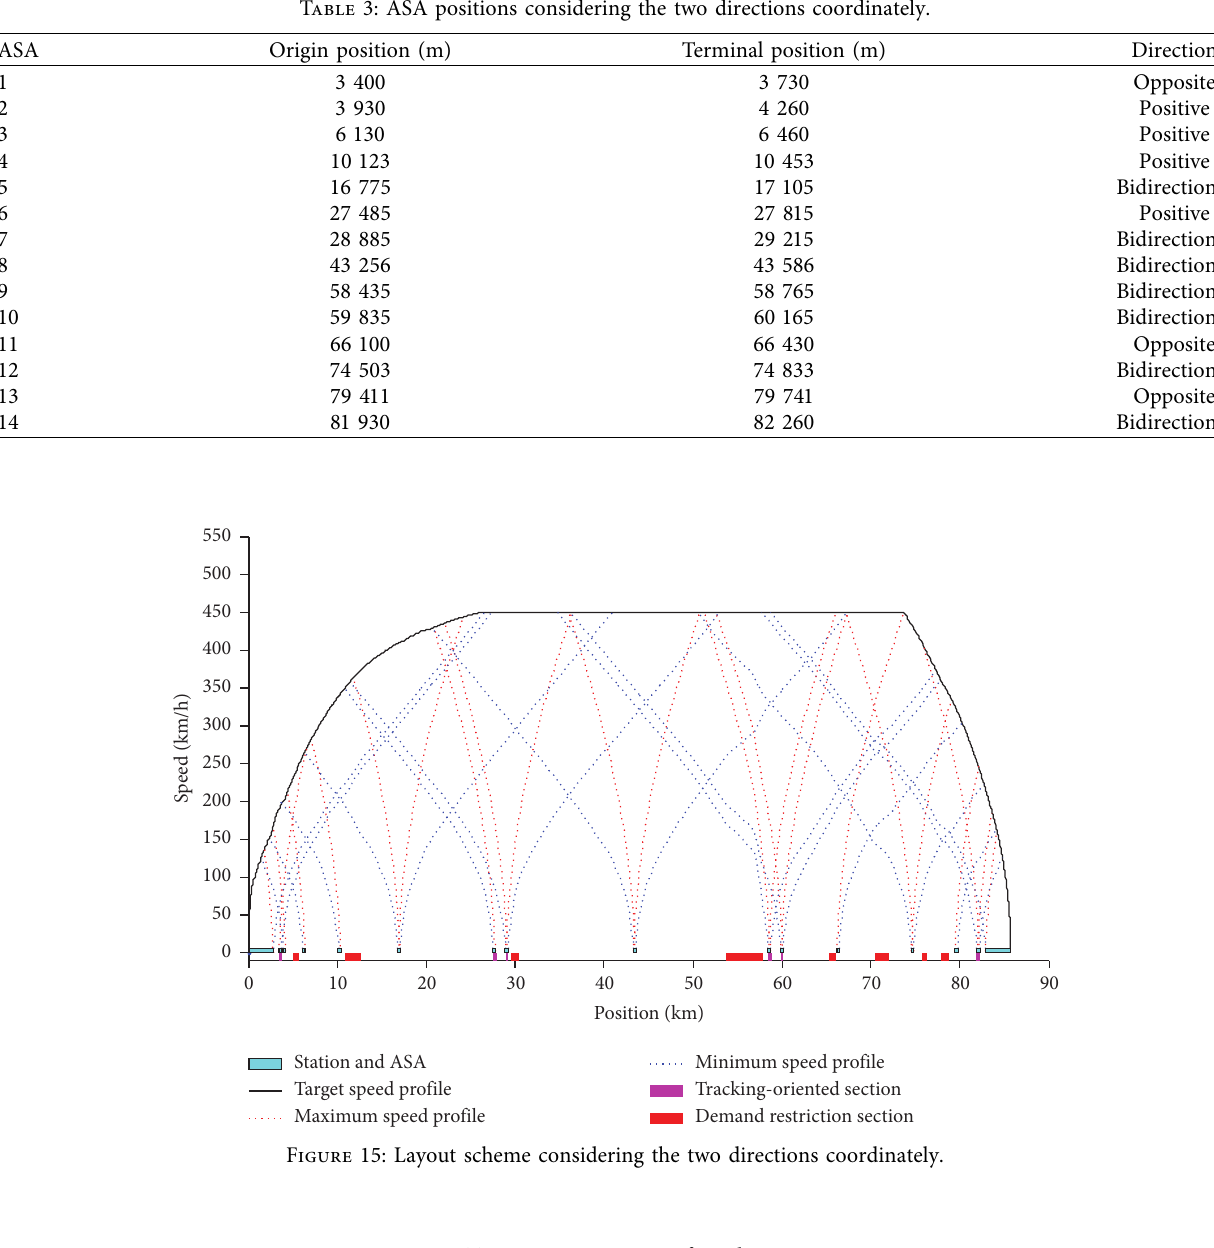
Table 4: Comparison of